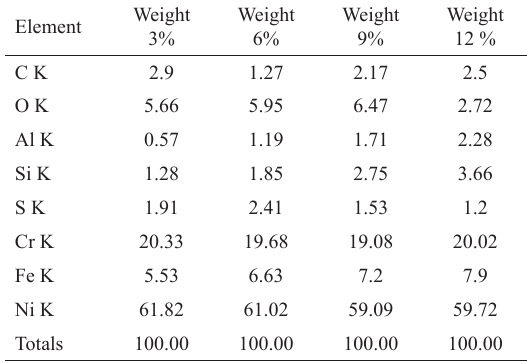
Table 3: Chemical composition by EDS of (a) 3% reinforcement, (b) 6% reinforcement, (c) 9% reinforcement, (d) 12% reinforcement.